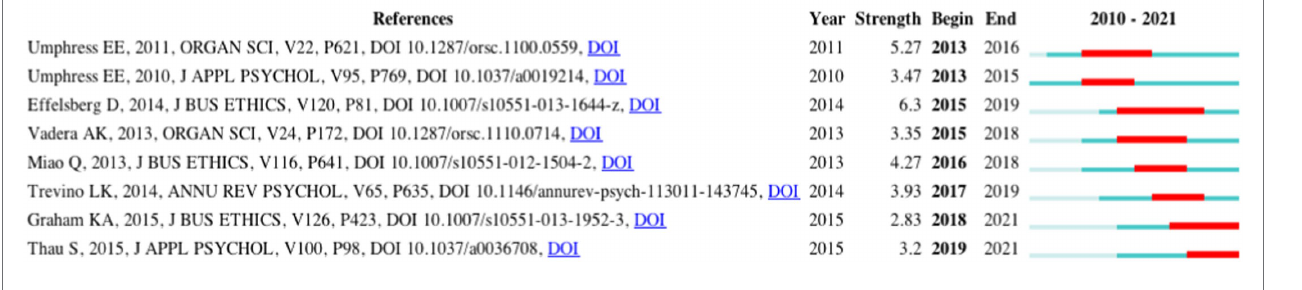
FIGURE 6 | Citation bursts analysis of references in UPB